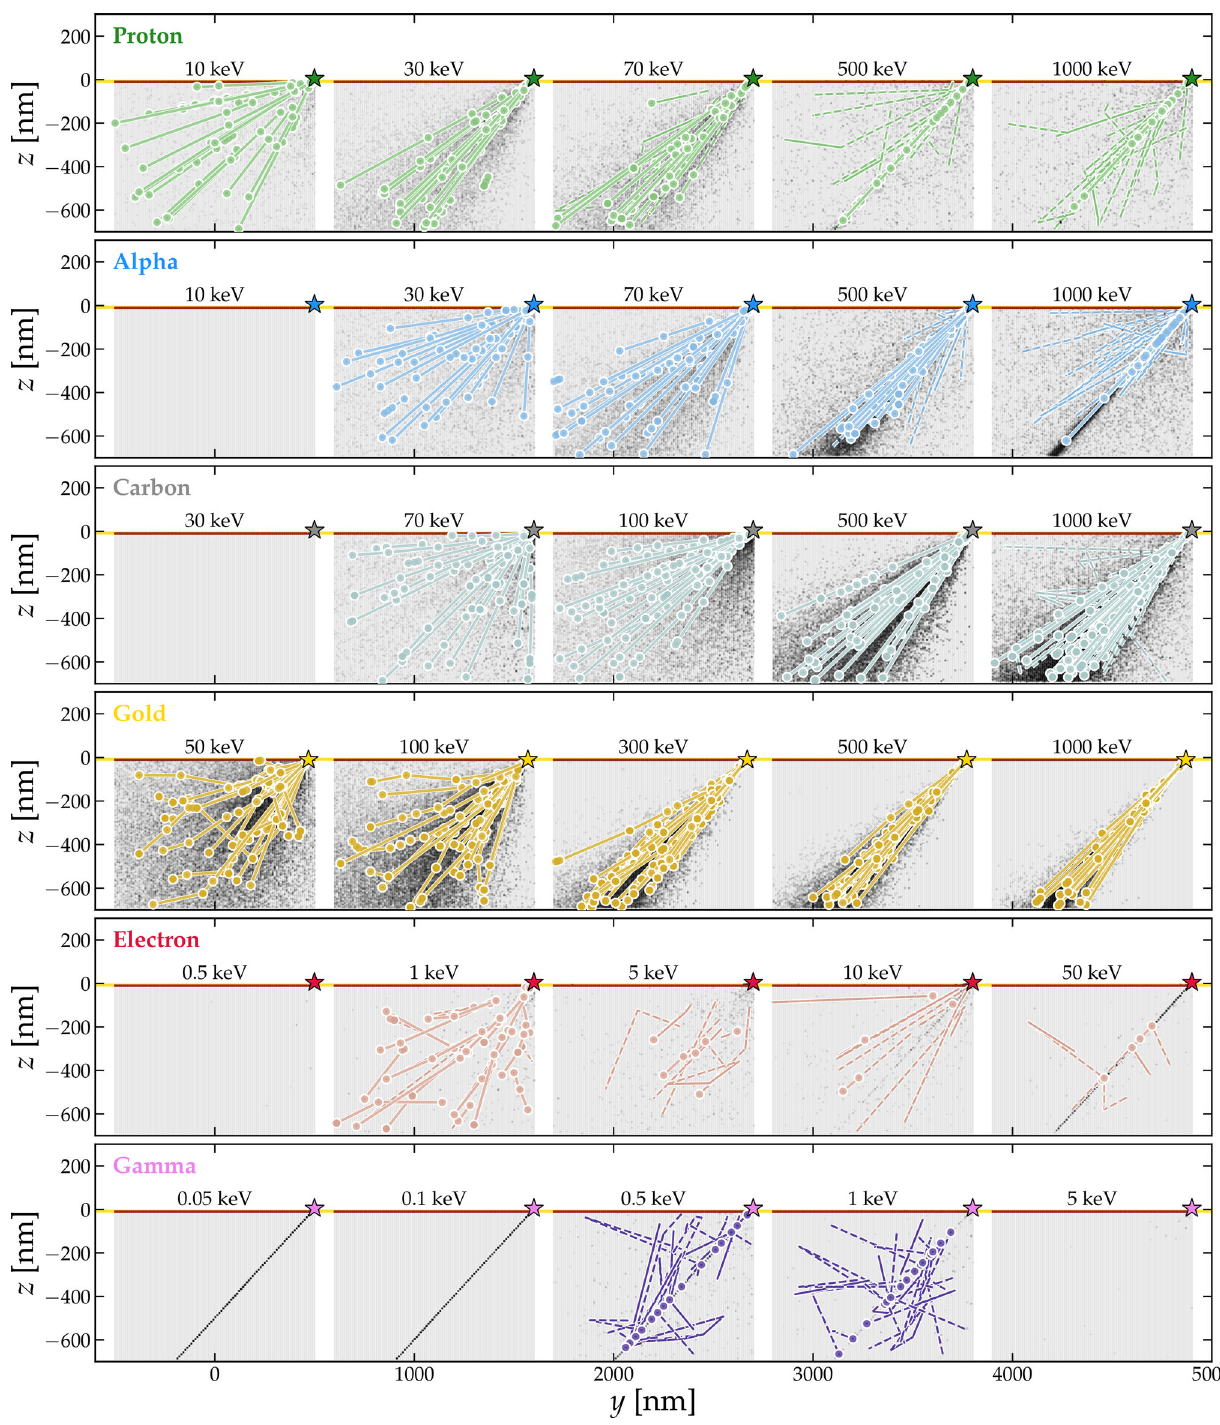
Fig. 12 Additional detailed images of strand breakage from beams angled at 45 ◦ to the holder. Each row corresponds to a different beam particle, and has five panels for different beam energies. The thick lines connected by circles correspond to the primary particle track, whereas